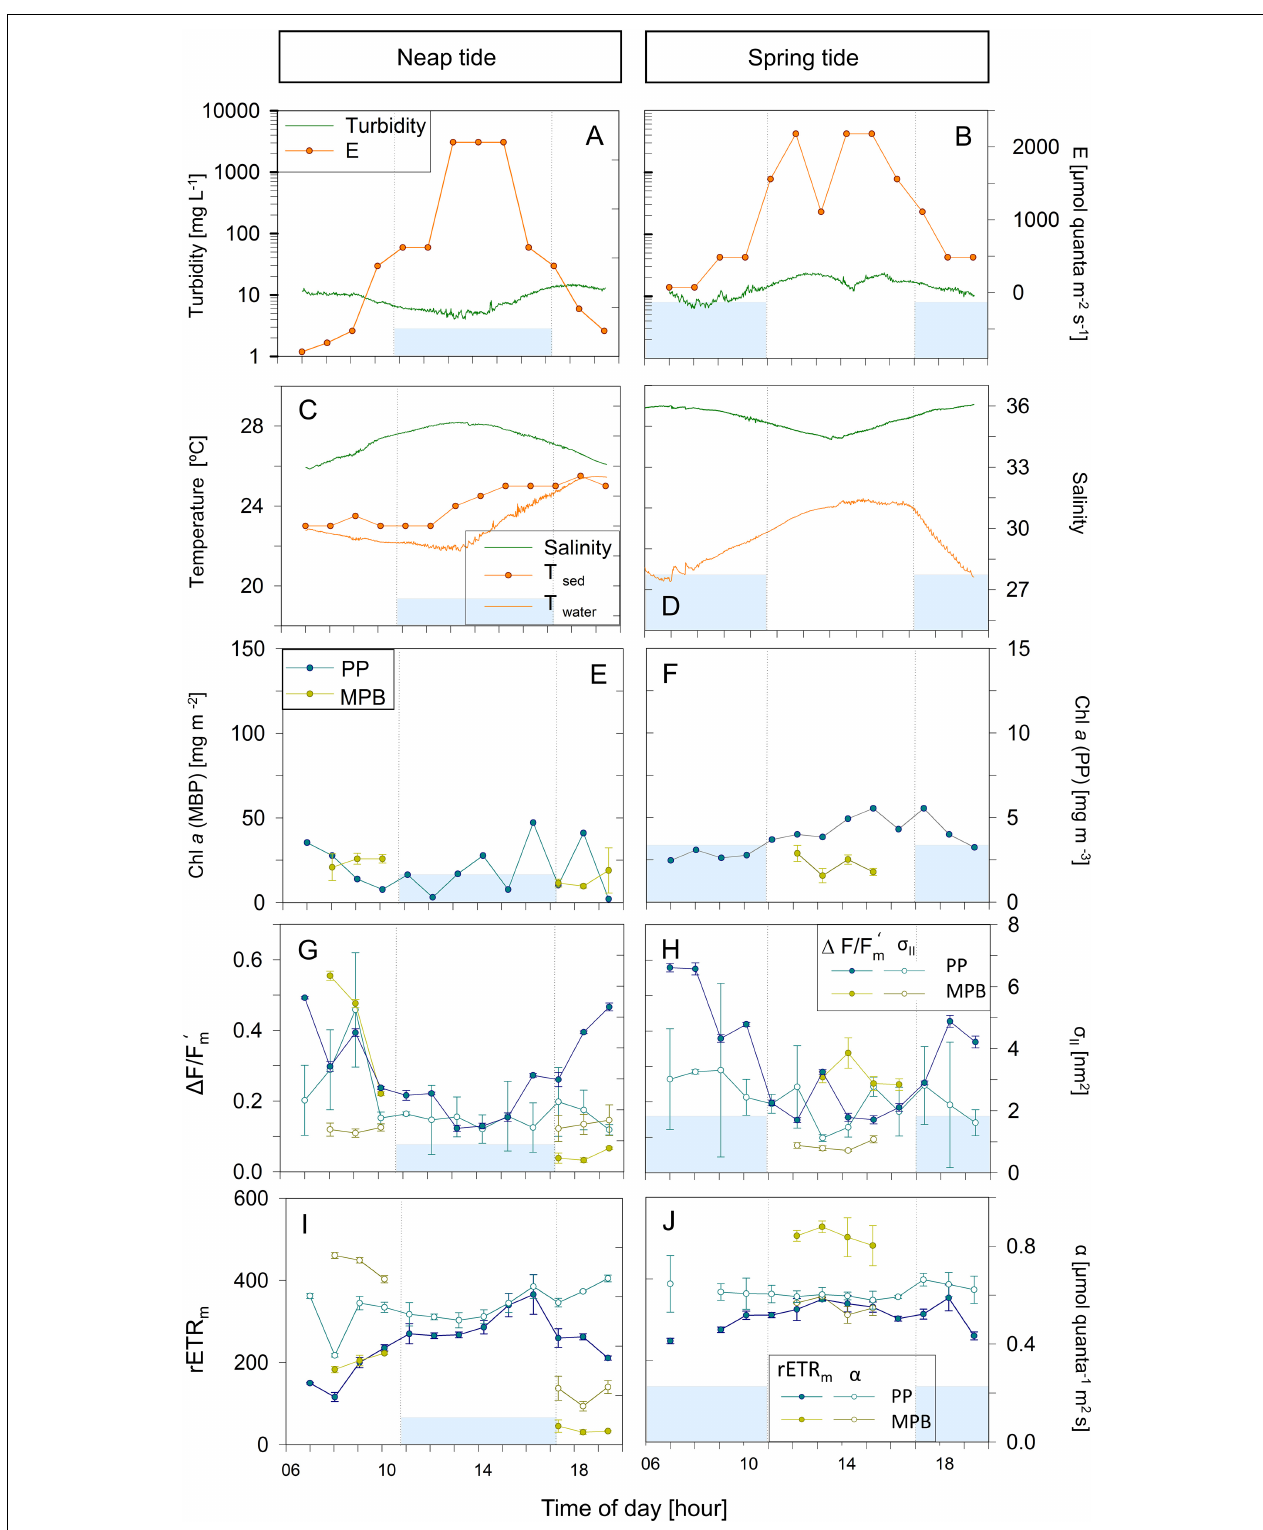
FIGURE 5 | Hourly variation of abiotic (A–D) and photophysiological (E–J) parameters along one day in Vista Alegre (VA) during neap (A,C,E,G,I) and spring tide (B,D,F,H,J) in July 2013. Blue areas represent high tide; vertical bars demonstrate the beginning and end of the high tide. Mean values of three replicates. Error bars represent one standard error. No temperature data available for the spring tide sampling day (D). PP, phytoplankton; MPB, microphytobenthos.